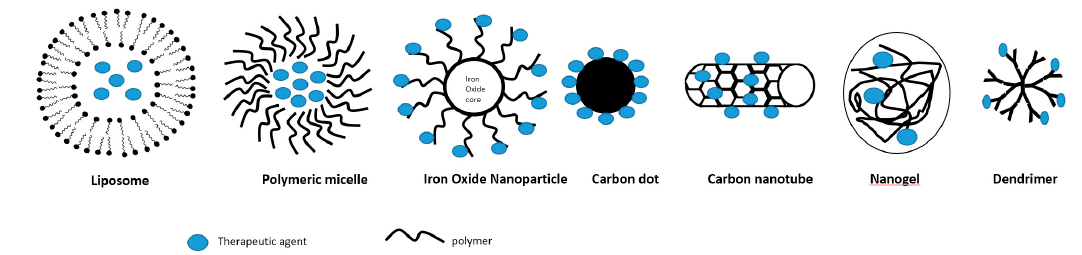
Figure 1. Schematic illustration of some nanocarriers.